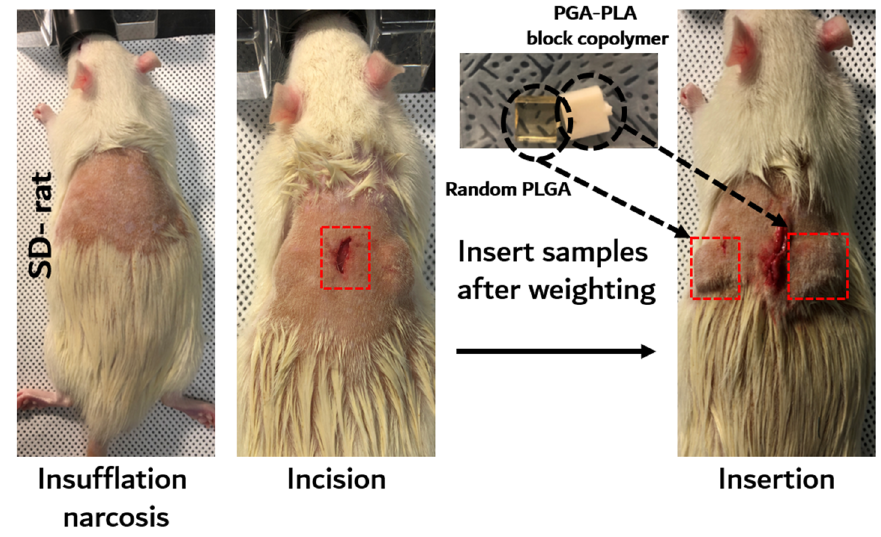
Figure 2. Scheme image of in vivo animal degradation test, which is sample insertion procedure.